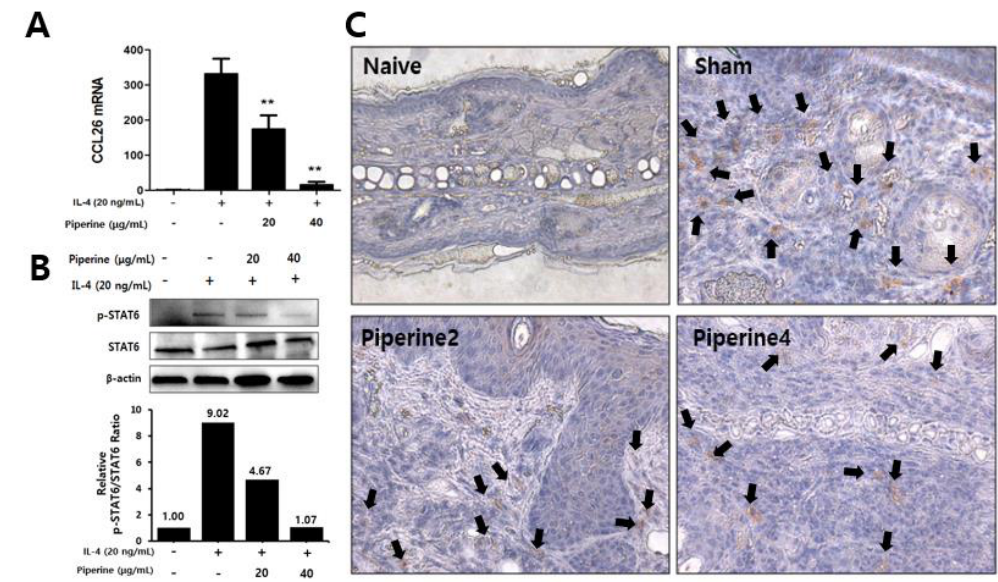
Figure 6. Effects of piperine on TMA-induced infiltration of CCR3 + cells in mouse ear tissues and IL-4-induced CCL26 mRNA expression and STAT6 phosphorylation in HaCaT cells. HaCaT cells pre-incubated with piperine were stimulated with IL-4 for 15 min and then incubated for 24 h to analyze ( A ) CCL26 mRNA expression and ( B ) STAT6 phosphorylation relatively. ( C ) Infiltration of CCR3 + cells into ear tissue was observed by immunohistological analysis. Black arrows indicate CCR3 + cells. The results are shown as the means ± SD ( n = 3). Asterisks (**) indicate significant differences between the piperine-treated and non-treated groups at p < 0.01.